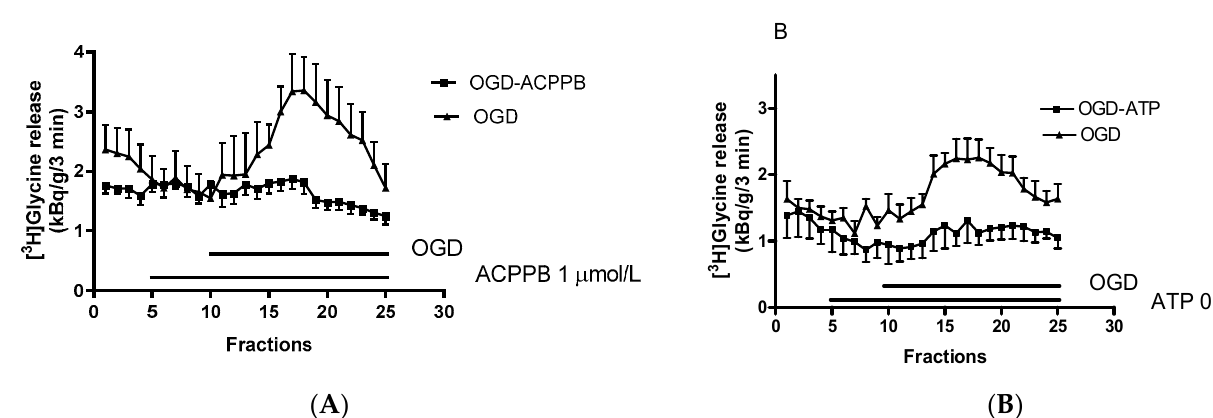
Figure 2. Oxygen and glucose deprivation (OGD)-induced [ 3 H]glycine release from rat retina. This release was reversed by addition of the GlyT-1 inhibitor ACPPB ( A ) and the P2 purinoceptor agonist ligand ATP ( B ). Posterior eyecups containing the retinae were prepared from male Wistar rats, loaded with 10 μ Ci [ 3 H]glycine for 30 min, and perfused with Krebs-bicarbonate buffer aerated with 95% O 2 /5% CO 2 gas mixture for 60 min; then 25 three-min fractions were collected. The perfusion rate was kept at 1 mL/min; [ 3 H]Glycine in the collected fractions and the tissue at the end of superfusion was determined and expressed as kBq/g/3 min. To evoke [ 3 H]glycine release, the eyecups were superfused with glucose-free Krebs-bicarbonate buffer saturated with 95% N 2 /5% CO 2 gas mixture added from fraction 10 and maintained through the experiment. The GlyT-1 inhibitor ACPPB, (Merck 13-h, glycine uptake inhibition IC 50 1.1 × 10 − 8 mol/L was determined in rat cerebral cortex synaptosomes) was added in a concentration of 10 − 6 mol/L from fraction 5 and maintained through the experiment [110,111]. ACPPB was synthesized by Professor Dr. Peter Matyus, Semmelweis University, Budapest, Hungary. ATP was added in a concentration of 10 − 4 mol/L from fraction 5 and maintained through the experiment. Data shown